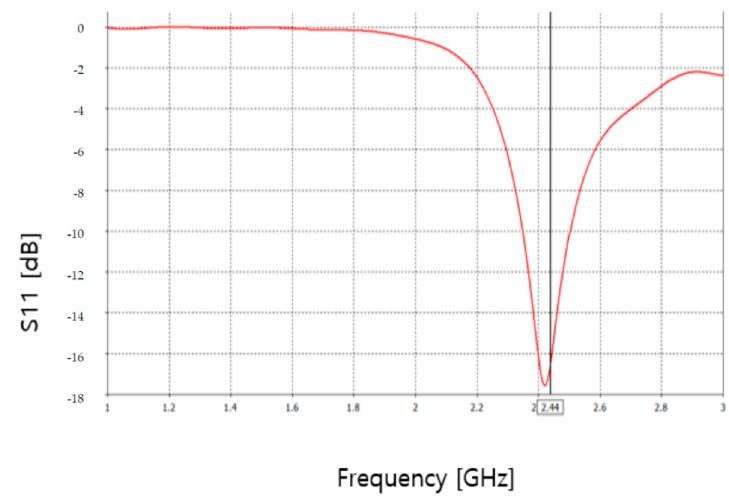
Figure 7. Scheme 11 of the proposed IFA antenna of the sensor module.